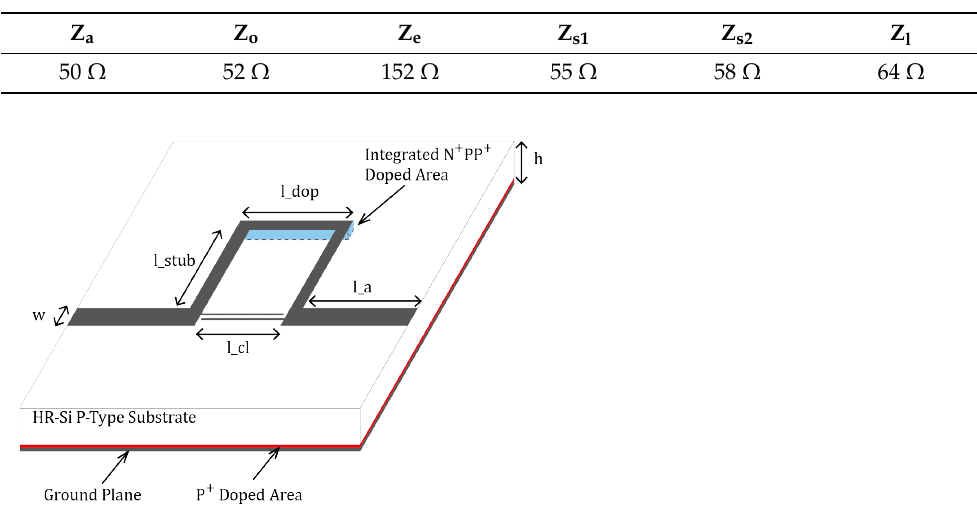
Table 5. Parameter values of the 10 GHz filter different elements from the synthesis. Table 6. Impedance values of the 10 GHz filter different elements.